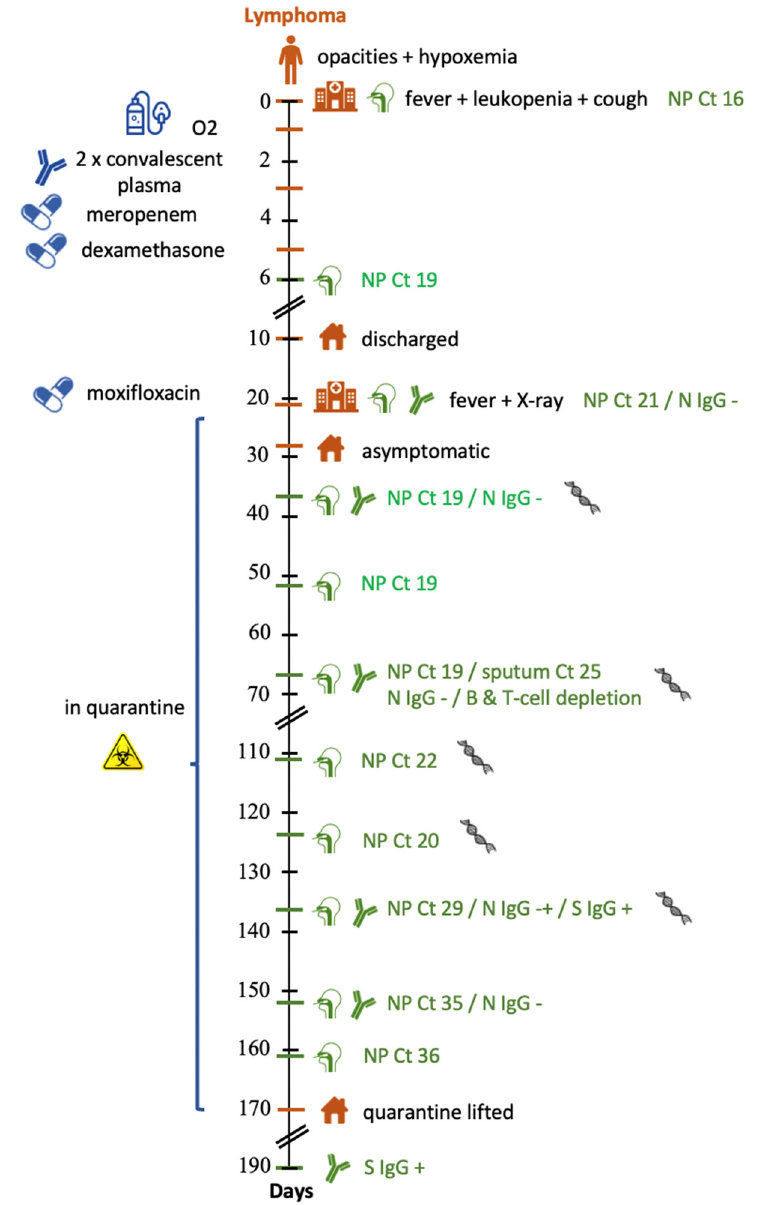
Figure 1. Schematic chronologic overview of the clinical course, sampling points and evolution of SARS-Cov-2 RT-qPCR Ct-value and antibodies. NP: nasopharyngeal specimen; Ct: SARS-CoV-2 RT-qPCR cycle threshold; N IgG: SARS-CoV-2 anti-nucleocapsid immunoglobulin; S IgG: SARS-CoV-2 spike protein immunoglobulin. Table 1. Overview of the evolution of SARS-CoV-2 RT-qPCR Ct-values, haematology and SARS-CoV-2 antibodies.